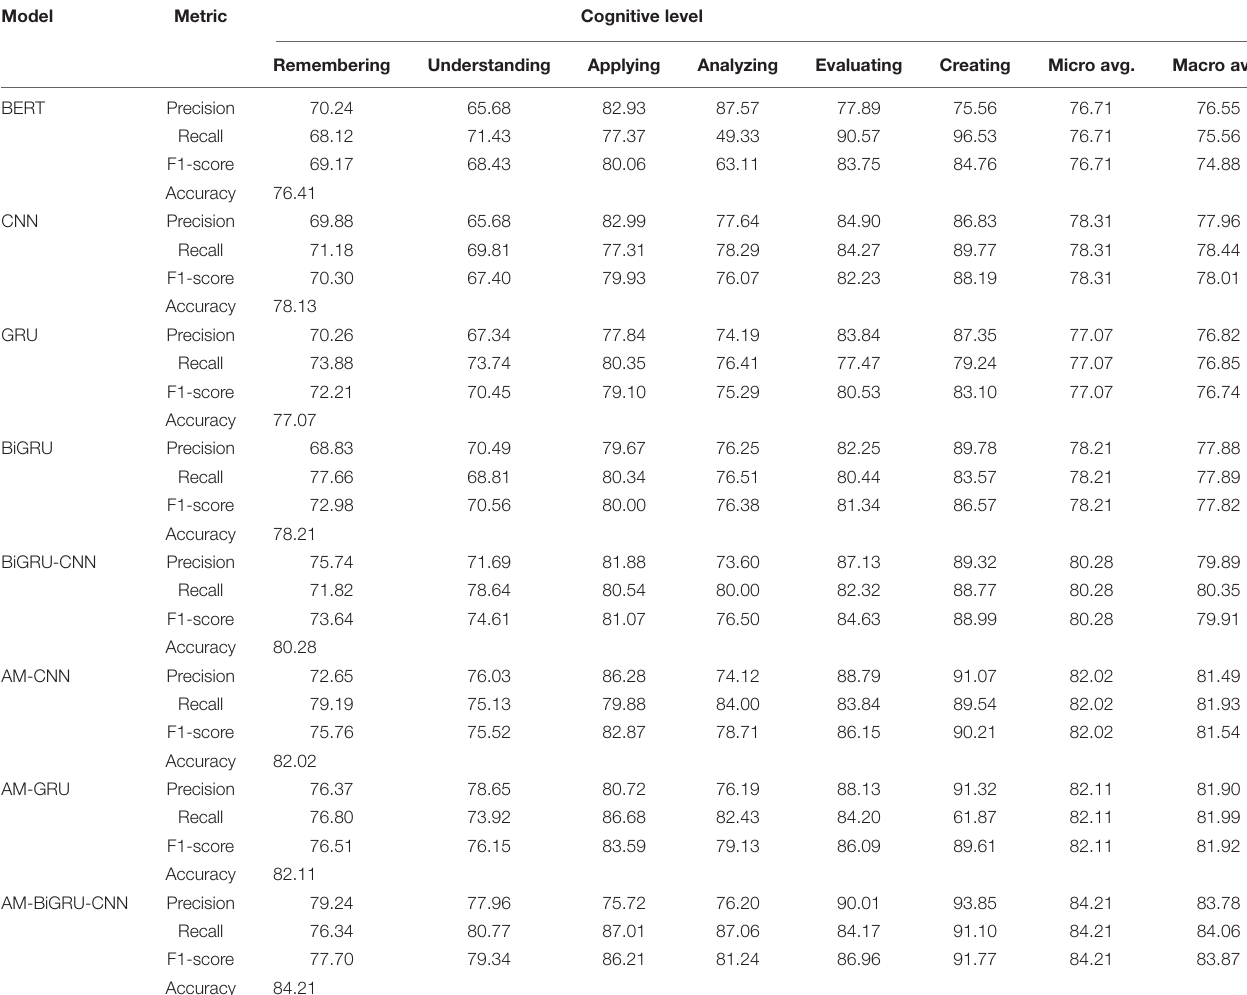
TABLE 4 | Experimental results of cognitive level